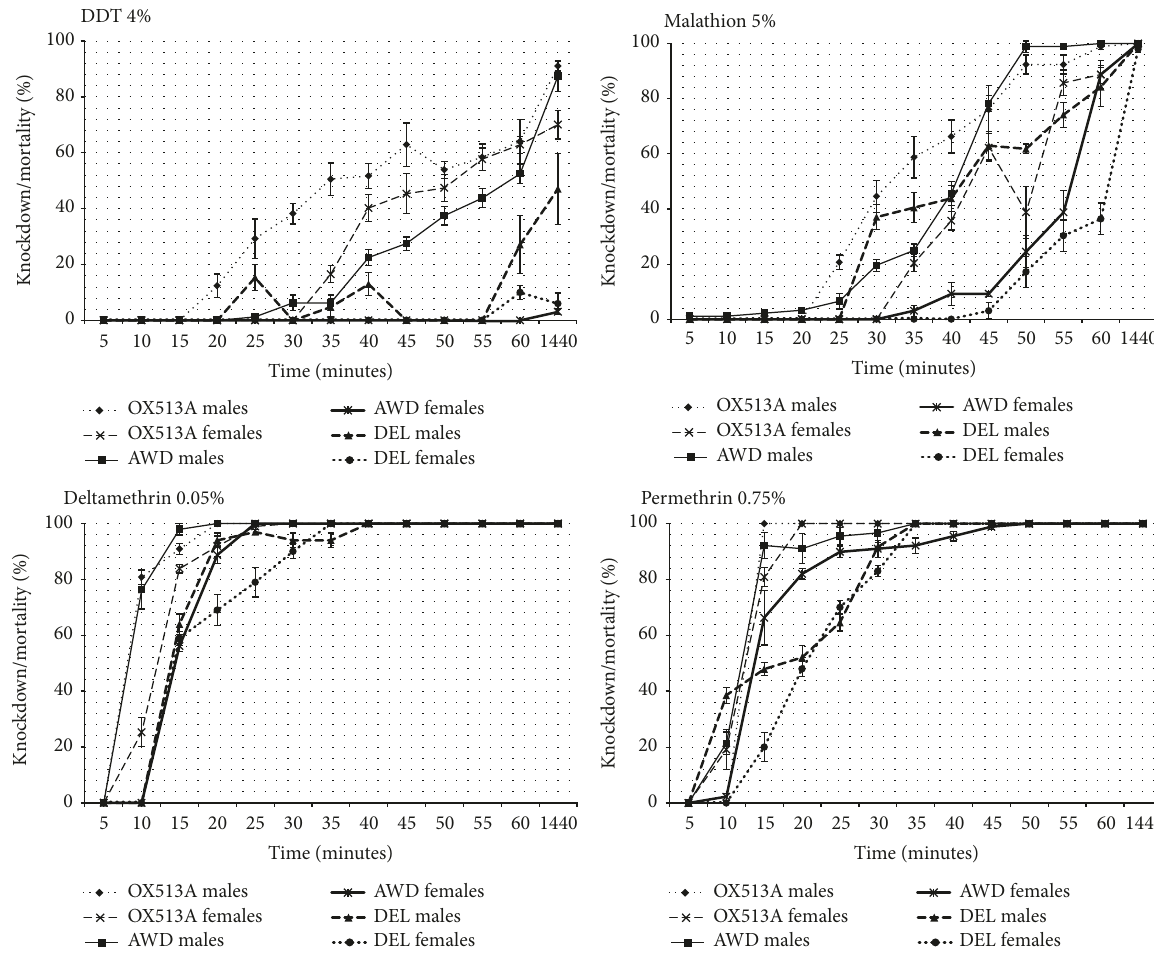
Figure 1: Knockdown/mortality percent of male and female adults of OX513A and wild-type Aedes aegypti from Aurangabad (AWD) and Delhi (DEL) against diagnostic concentrations of four synthetic insecticides. Error bars indicate standard